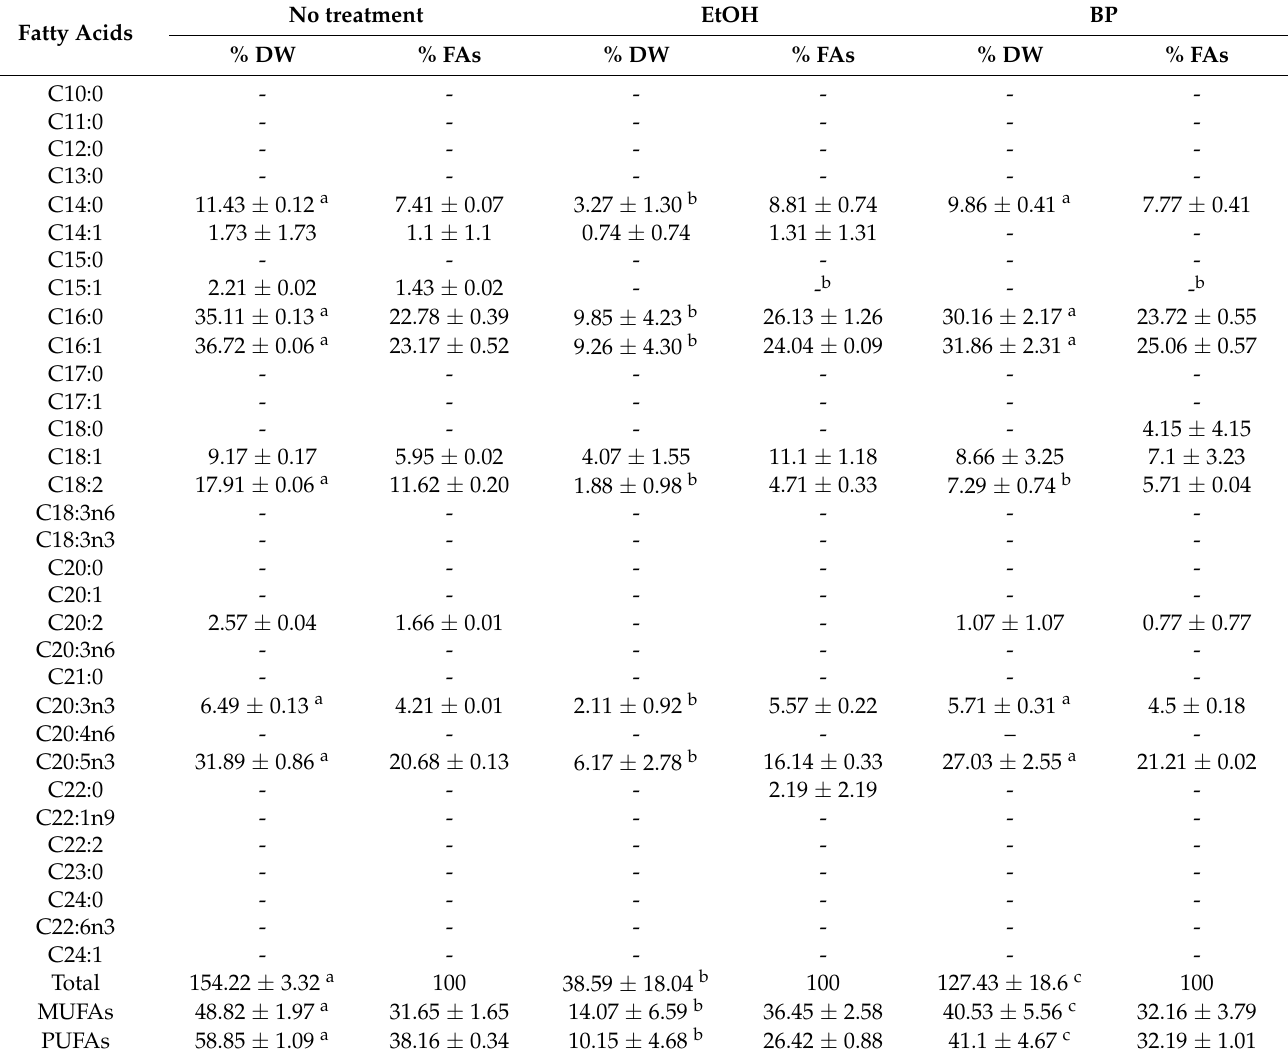
Table 5. Fatty acid profile and content on dry weight (DW) basis for nontreated and residual biomass after EtOH and BP